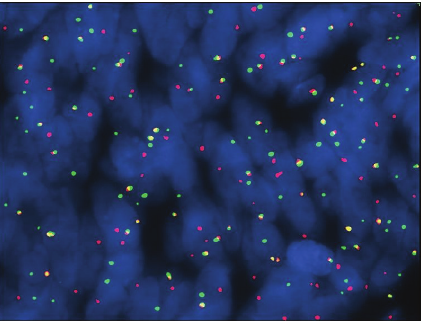
Figure 5: Photomicrograph of FISH results showing splitting of the fluorescent signal revealing SYT